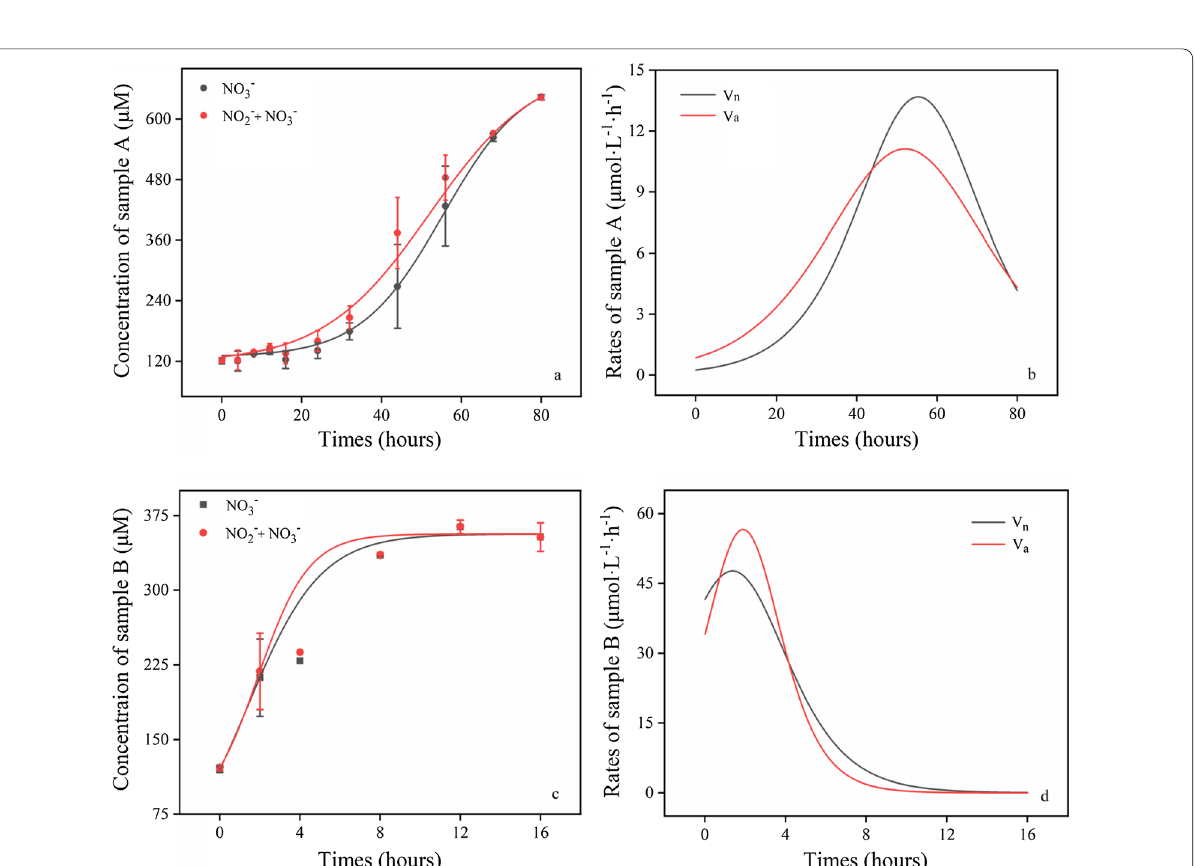
Fig. 1 Boltzmann fitted curves ( a , c ) and differential curves ( b , d ) from Boltzmann fitting equations of the DIN time series for instantaneous rates of ammonia oxidation (Va) and nitrite oxidation (Vn) of the water